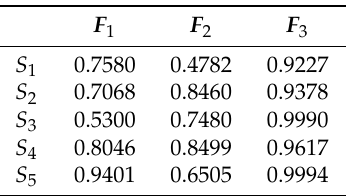
Table 3. Entropy